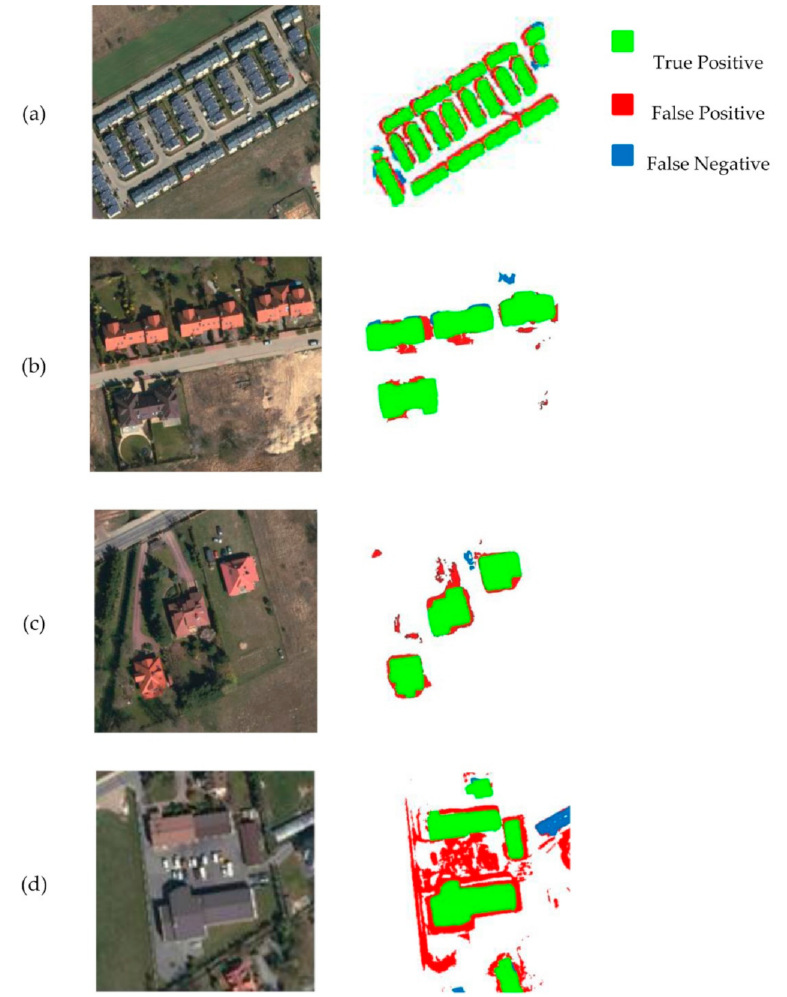
Figure 8. Results of RGB orthoimagery segmentation based on U-Net: ( a ) dense built-up area; ( b ) multiple colors of roofs; ( c ) complex roof shapes and vegetation vicinity; ( d ) complex pattern of buildings, parking lots,